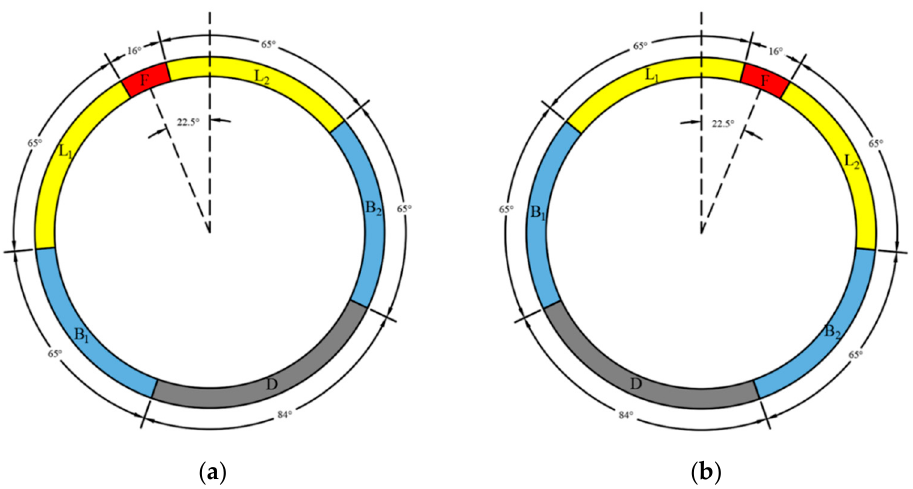
Figure 15. Staggered joint assembly of the shield tunnel in this study, where: ( a ) ring number is odd, and ( b ) ring number is even.